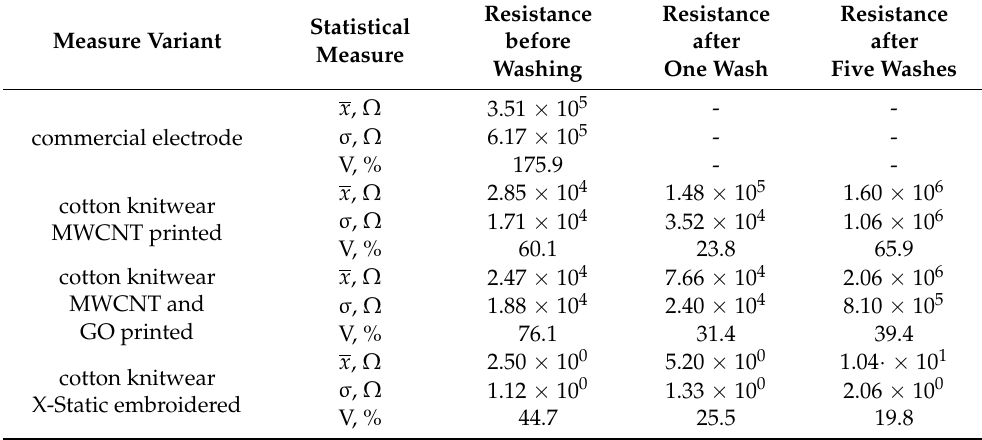
Table 7. Results of average values of surface resistances in test materials after